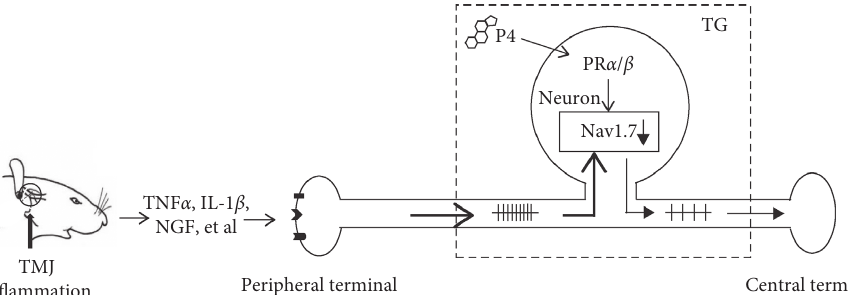
Figure 5: A model diagram of progesterone attenuating allodynia of inflamed temporomandibular joint (TMJ) through modulating voltage-gated sodium channel 1.7 in trigeminal ganglion. TMJ inflammation induces expressions of cytokines, such as TNF α , IL-1 β , and NGF. These cytokines will act on the nerve endings, initiate impulse, and induce Nav1.7 expression in the TG. P4 may downregulate trigeminal ganglionic Nav1.7 expressions, which reduce the stimuli in the neurons, through progesterone receptors (PR α / β ), and then attenuates allodynia of inflammatory